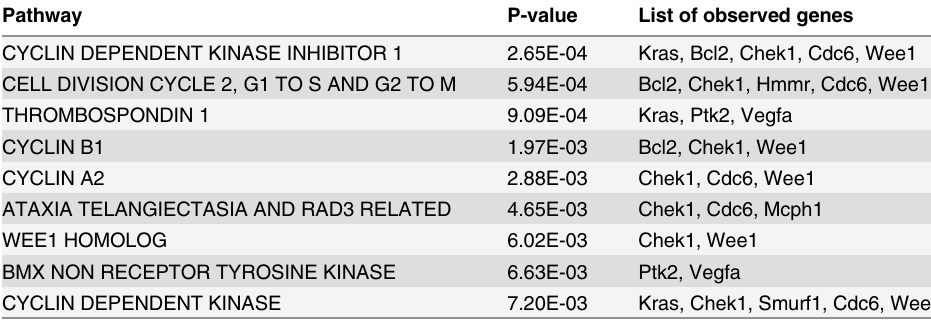
Table 2. Collective targeting of cell cycle genes.